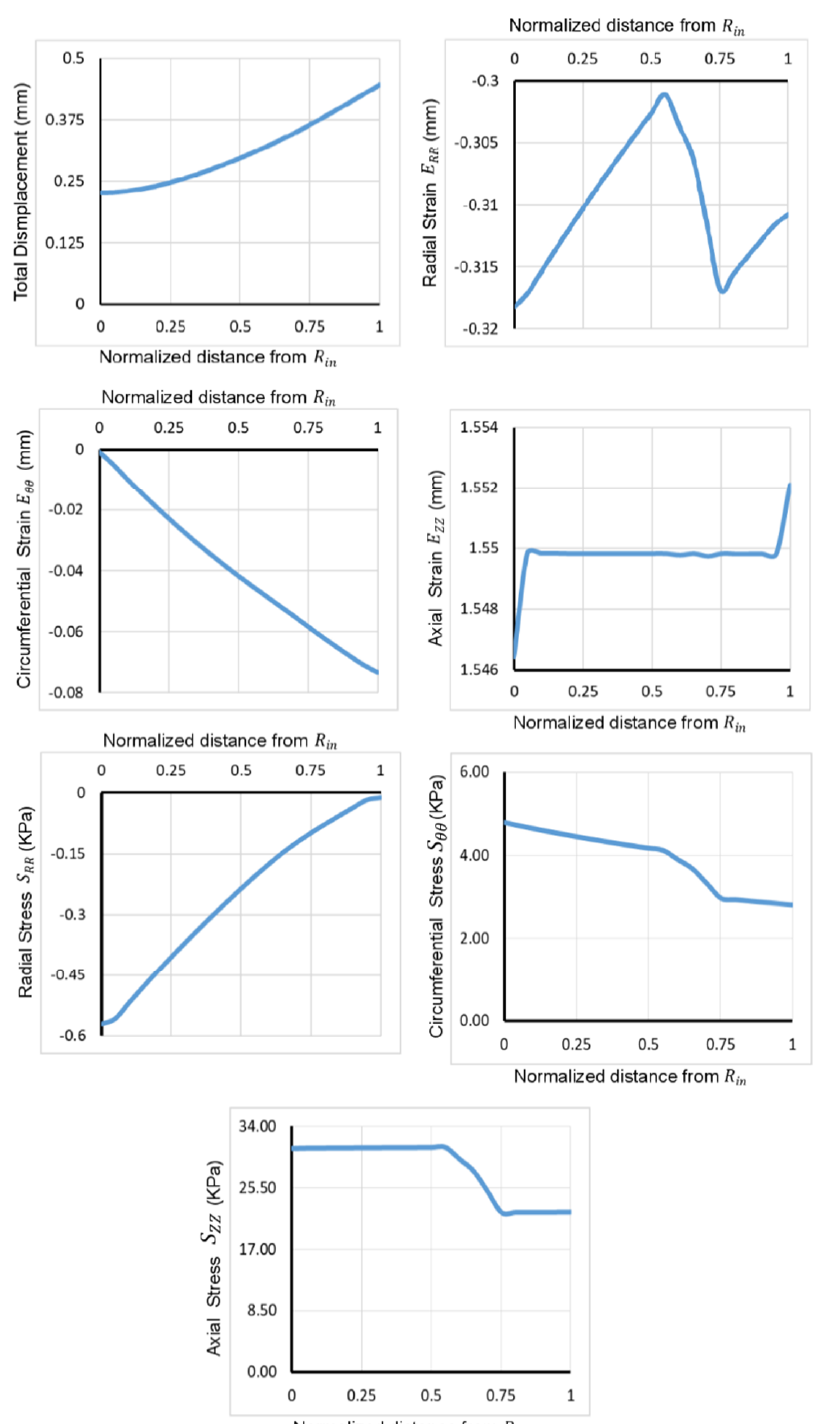
Figure 7. Dispacement, strain and stress in di ff erent directions across the thickness of intestinal wall calculated from computataional model results.